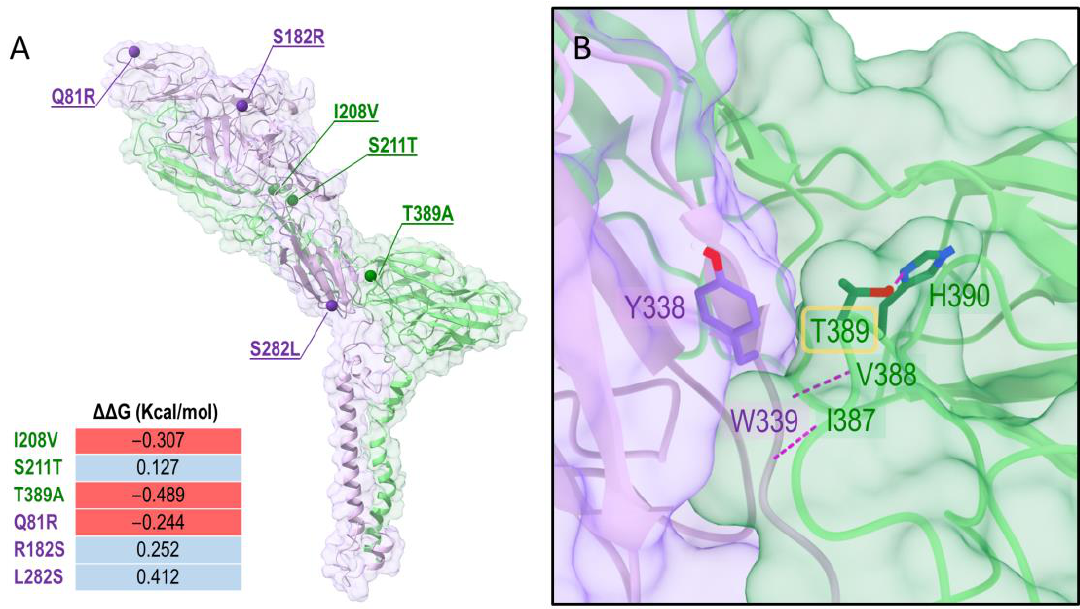
Figure 2. E1/E2 heterodimer model ( A ) and zoomed view of the interface between E1 and E2 at the position T389 ( B ). E1 and E2 are colored in lime green and violet, respectively. Cartoon and transparent surface styles are used. ( A ) Positions affected by mutations in E1 and E2 are shown as dark green and purple spheres, respectively. Calculated ΔΔG values for each mutant are reported. ( B ) Hydrogen bonds are represented as purple dashed lines. Only residues involving side chains in the interactions are shown and labeled: Y338 in E2 and T389 and H390 in E1 are displayed as sticks with atom-type coloring. The images were prepared with ChimeraX [35].